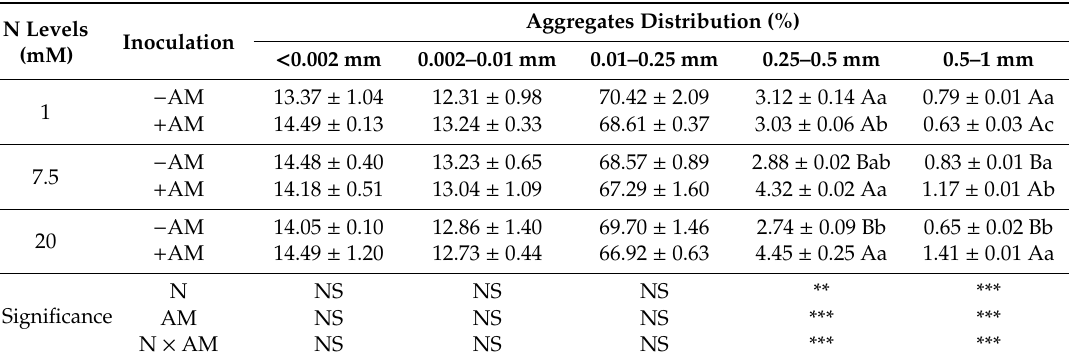
Table 2. Composition of rhizosphere soil aggregates under di ff erent N application